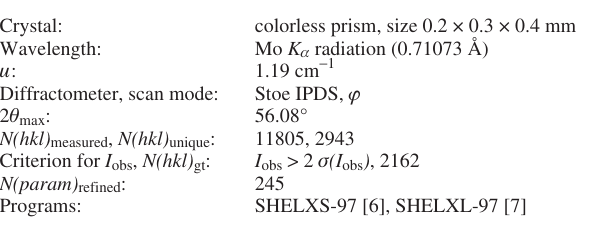
Table 1. Data collection and handling.